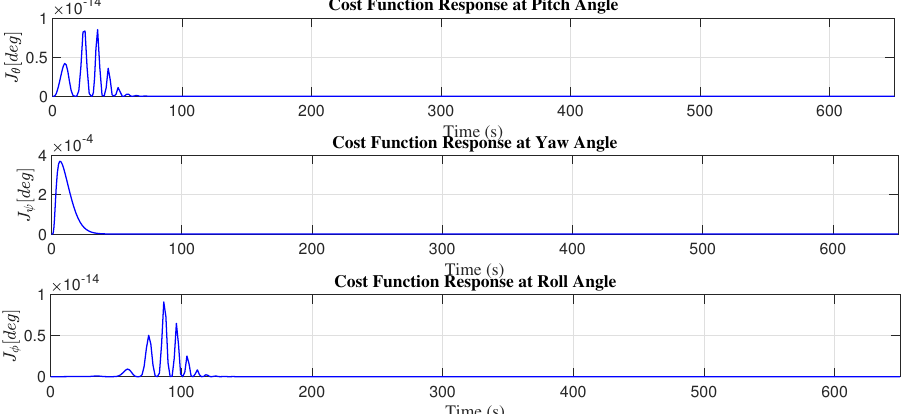
Figure 11. Controller response with MIT rule.